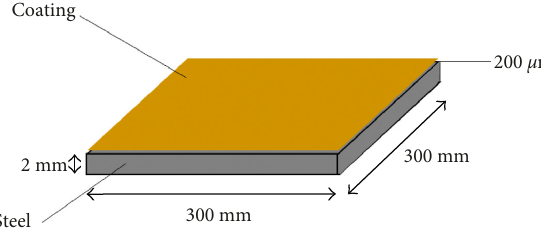
Figure 1: Sketch of coating applied on the steel